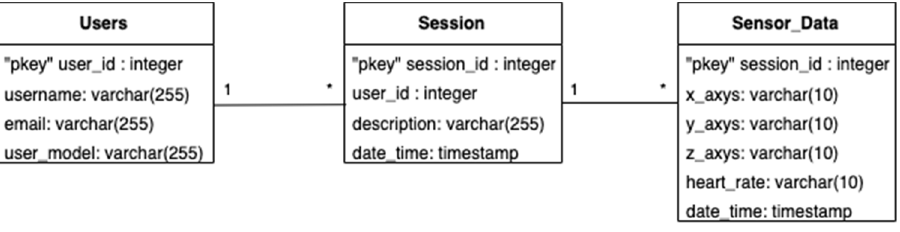
Figure 25. Example of data in the “Session” table.